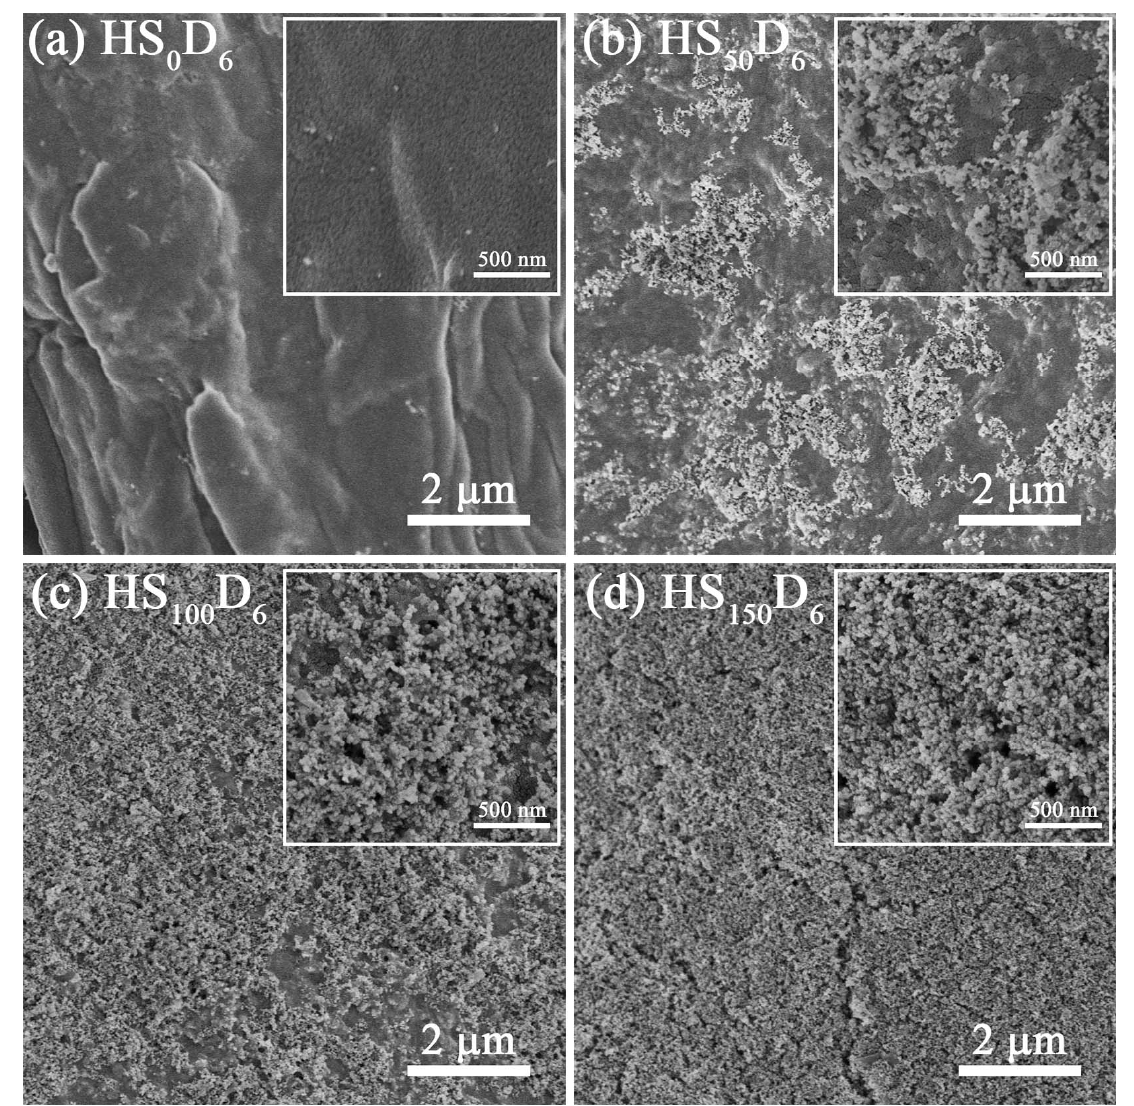
Figure 7. ( a ) Water contact angle of HS n D 6 coated paper. ( b ) Change of WCA of HS 150 D 6 coated paper.